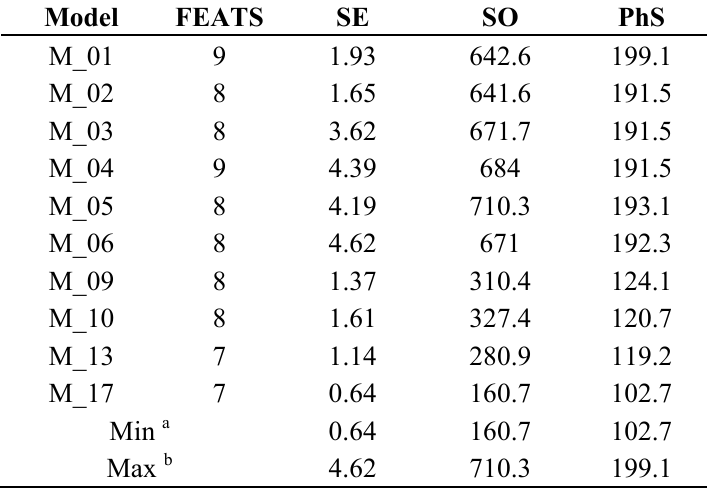
Table 2. Strain energy (SE), steric overlap (SO) and pharmacophoric similarity (PhS) values for GALAHAD models with all five ligands with contribution to the consensus feature.